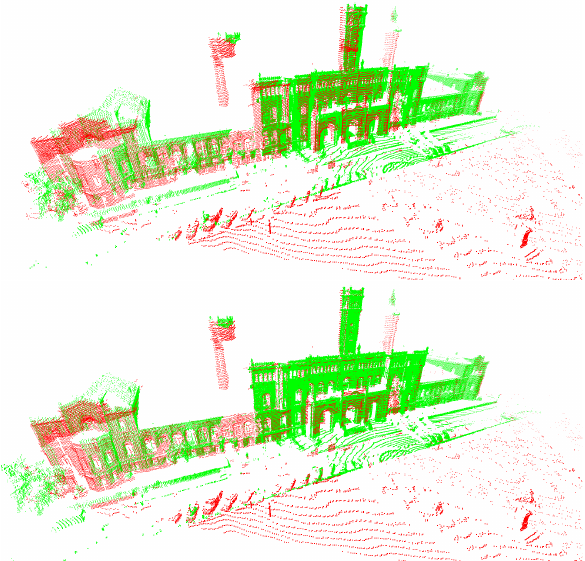
Figure 5: ICP process applied to the Welfeschloss point cloud with coarse subject from the mobile laser scanner (red), and dense reference from terrestrial laser scanner